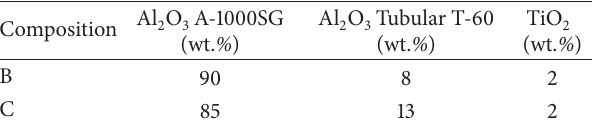
Table 2: Ceramic compositions.